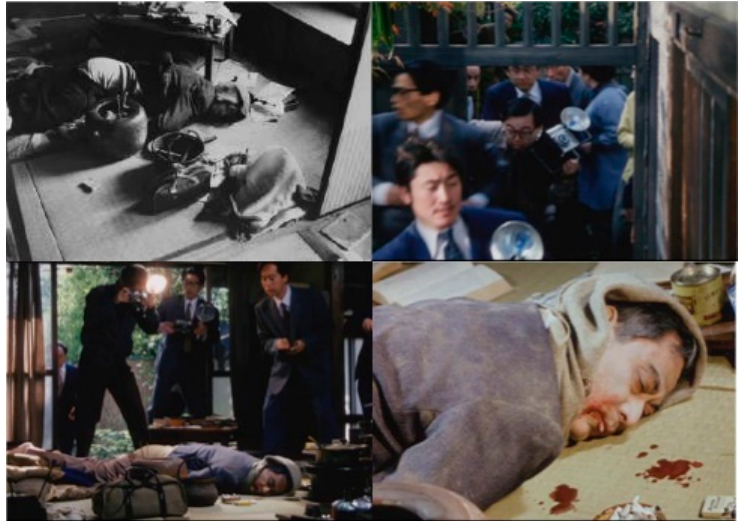
Figure 13. The Strange Story of Oyuki (Shind ō Kaneto, 1992).